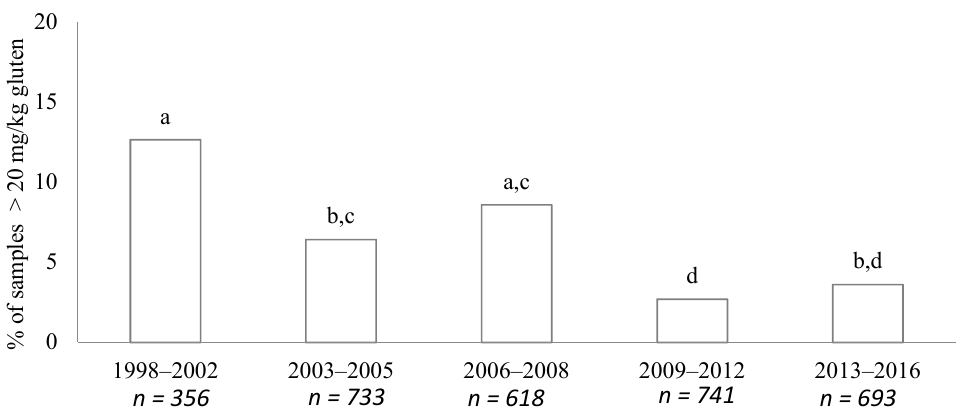
Figure 1. Evolution of gluten-containing samples (>20 mg/kg), sorted by five periods (1998–2002, 2003–2005, 2006–2008, 2009–2012, and 2013–2016). Data are expressed as the percentage of total samples analyzed in each period. Bars not sharing a common letter (a, b, c, d) are significantly different ( p < 0.05).